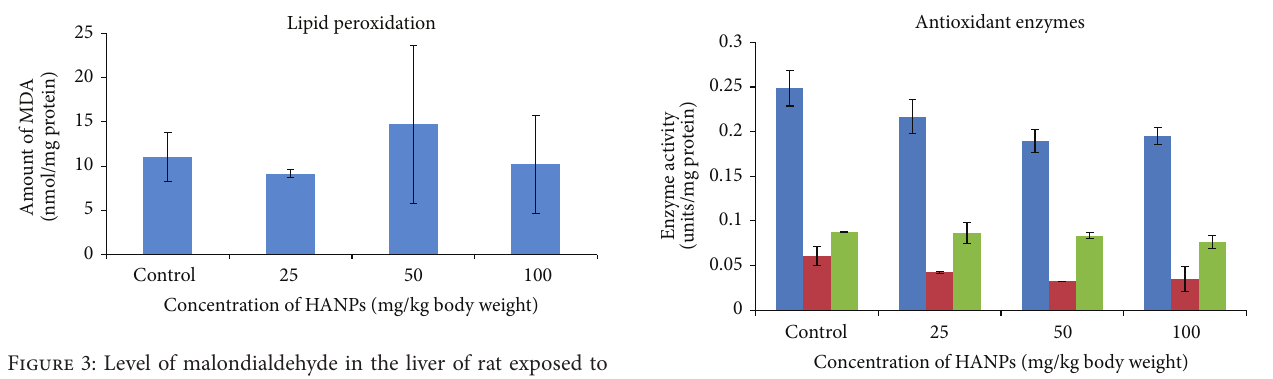
Figure 3: Level of malondialdehyde in the liver of rat exposed to HANPs (mean ± SD, 𝑛 = 5 ).